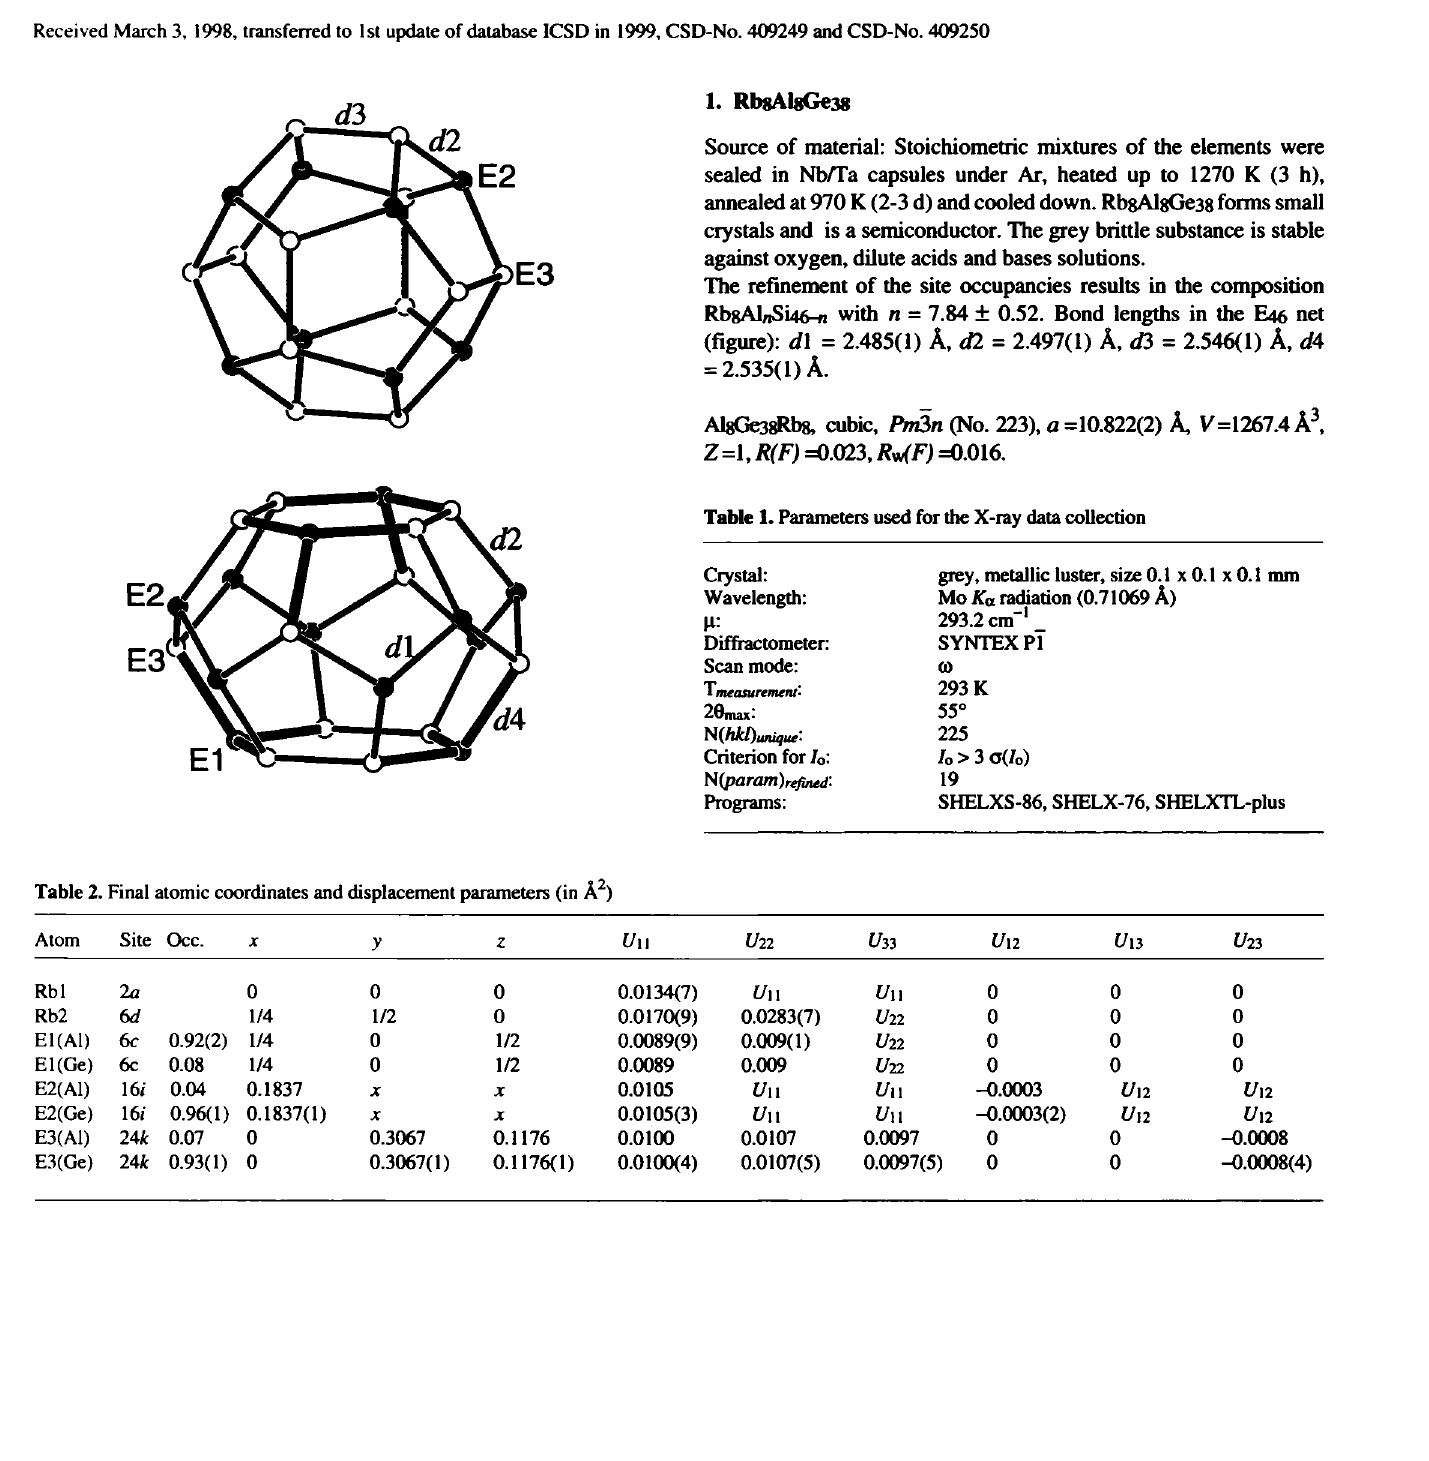
(figure): dl = 2.485(1) k, dl = 2.497(1) Â, <0 = 2.546(1) Â, d4 = 2.535(1) Â.